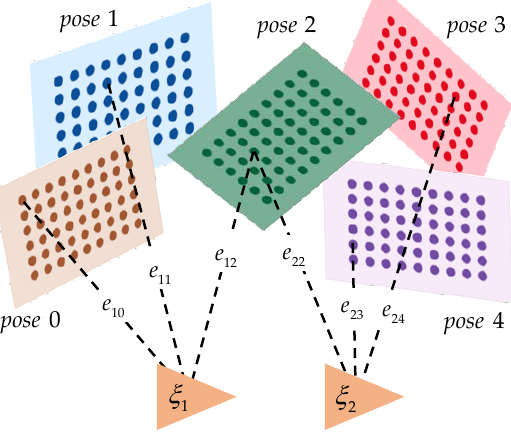
Figure 7. Joint calibration graph optimization model.